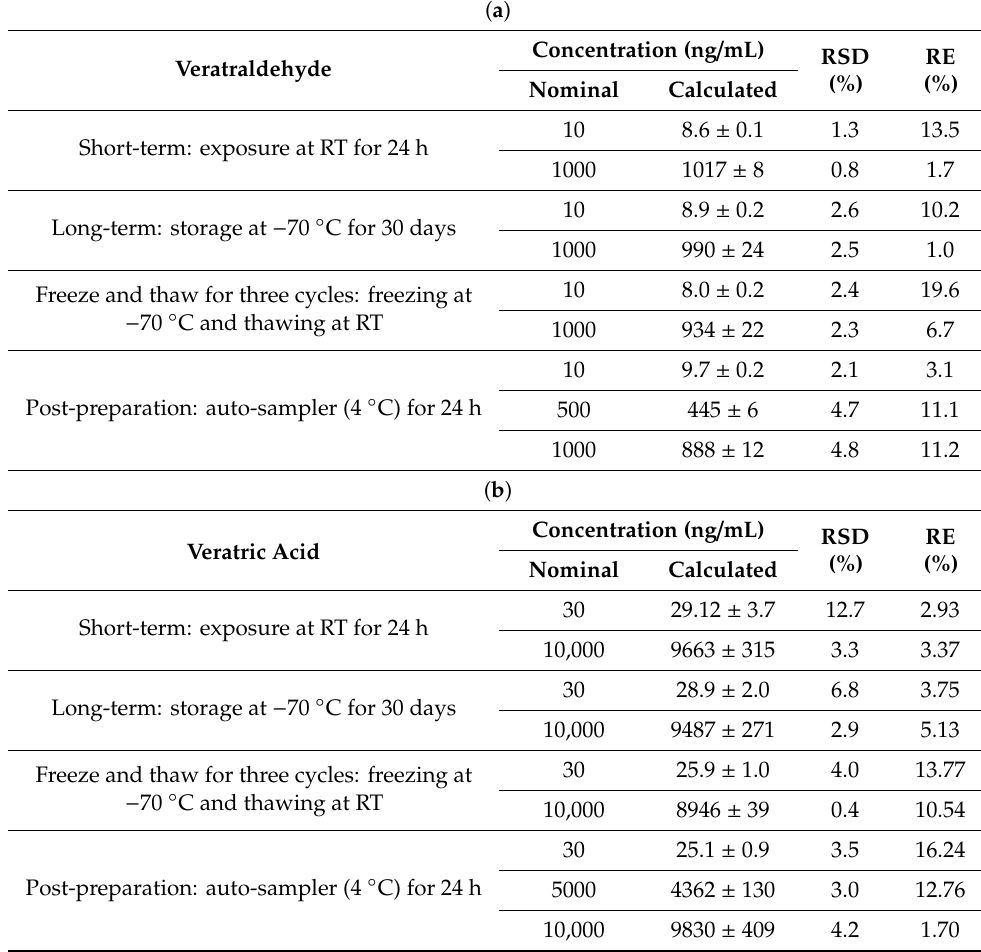
Table 4. Stability results of ( a ) veratraldehyde and ( b ) veratric acid in rat plasma ( n =